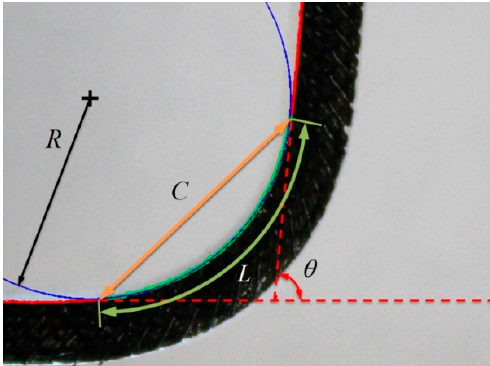
Figure 12. Processed image of activated actuator with parameters from the optimization labeled.